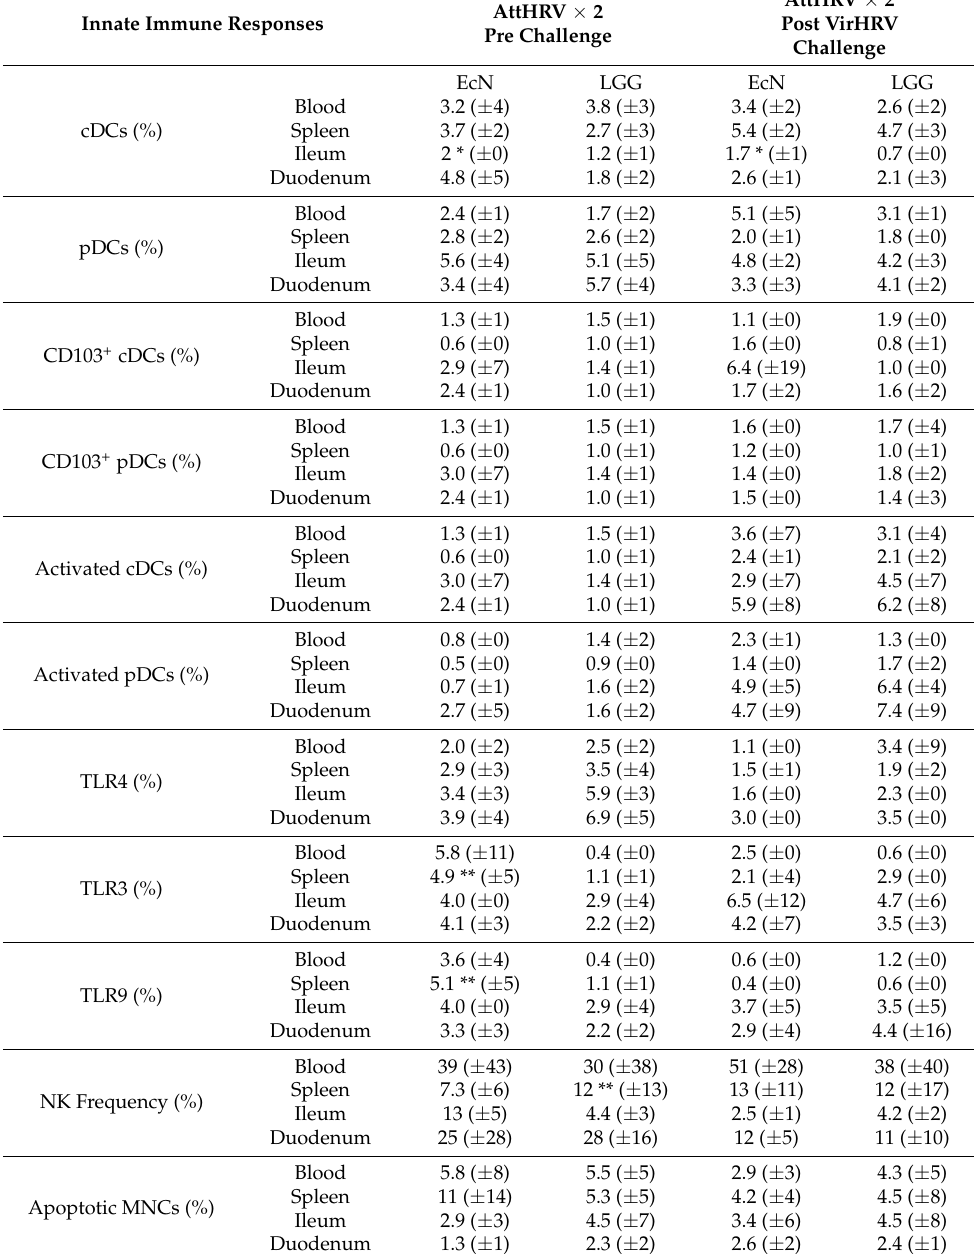
Table 4. EcN colonization altered the frequencies of cDCs, pDCs, CD103 + cDCs/pDCs, activated cDCs/pDCs, Toll like receptor-expressing mononuclear cells, natural killer cell frequency, and apoptotic MNCs in